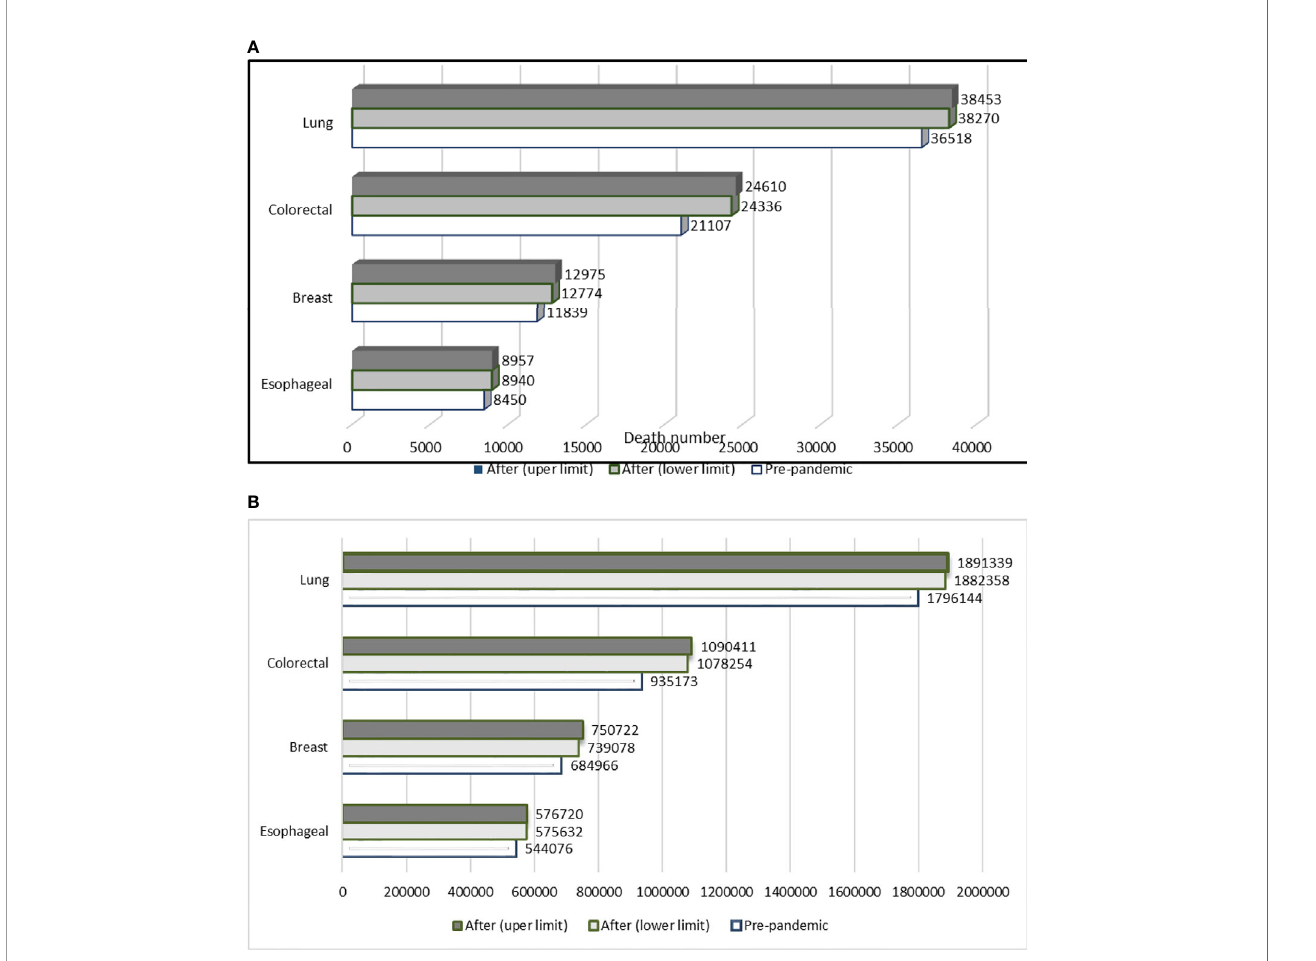
FIGURE 3 | (A) Estimated cumulative number of deaths in the UK due to breast, colorectal, lung, and esophageal cancers up to year 5 after the diagnosis. (B) Estimated cumulative numbers of deaths throughout the world due to breast, colorectal, lung, and esophageal cancer up to 5 years after the diagnosis (Calculated numbers are an estimate). Based on the data published by Maringe and coworkers, we anticipate a minimum 7.9 – 9.6%, 15.3 – 16.6%, 4.8 – 5.3%, and 5.8 – 6.0% increase in the numbers of deaths due to breast, colorectal, lung, and esophageal cancer, respectively, up to year 5 after the diagnosis (38,